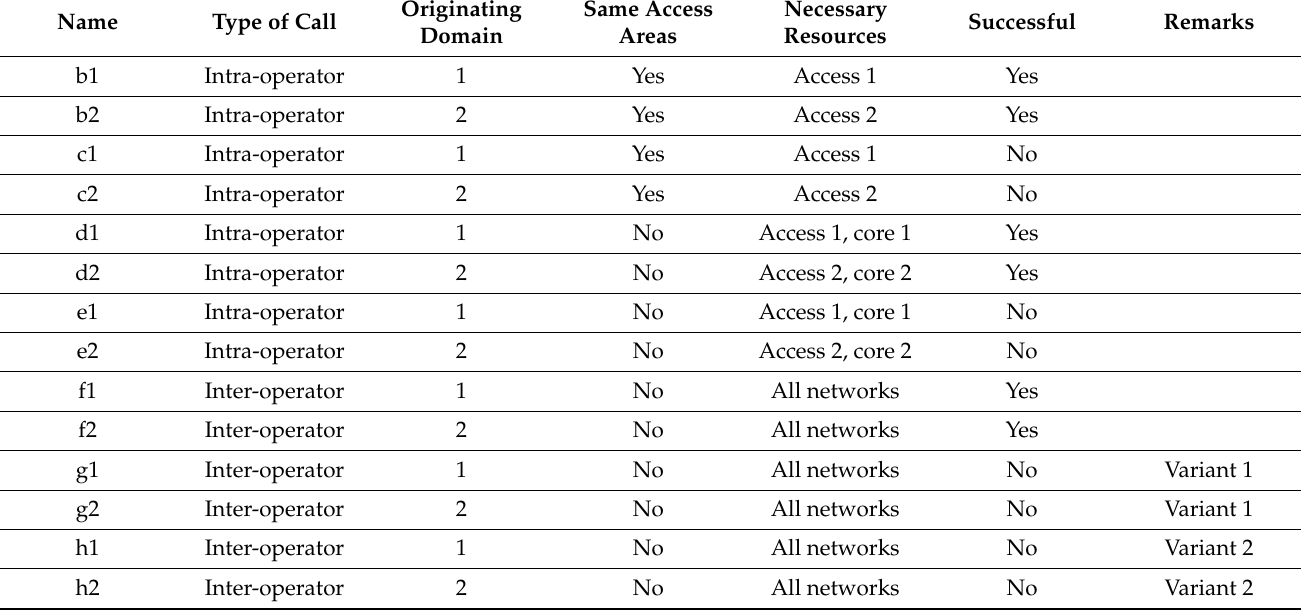
Table 1. Call scenarios in the modeled IMS/NGN